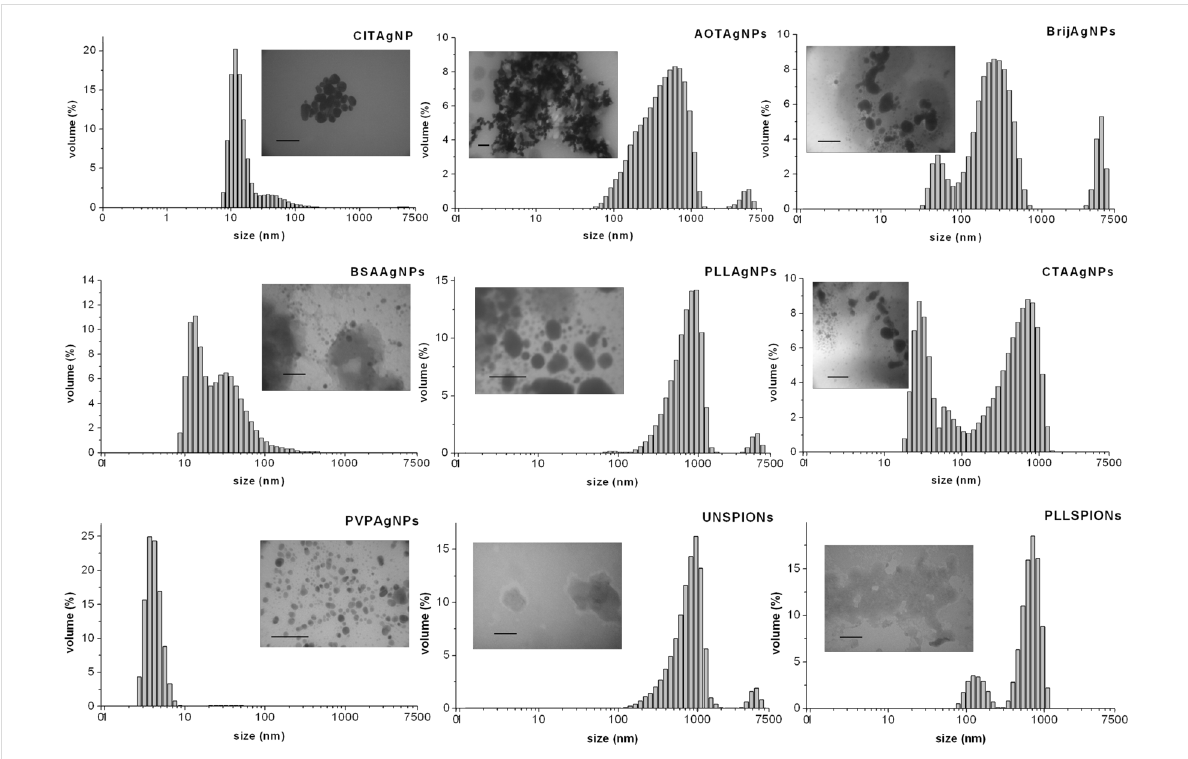
Figure 6: Transmission electron micrographs (TEM) and corresponding size distributions by volume of differently coated metallic nanoparticles in bio- logical media after 1 h at 25 °C. Results are presented for silver nanoparticles coated with trisodium citrate (CITAgNP), sodium bis(2-ethylhexyl) sulfo- succinate (AOTAgNP), Brij 35 (BrijAgNPs), bovine serum albumin (BSAAgNPs), poly(L-lysine) (PLLAgNP) , cetyltrimethylammonium bromide (CTAAgNP), and poly(vinylpyrrolidone) (PVPAgNP) and superparamagnetic iron oxide nanoparticles uncoated (UNSPION) and coated with poly(L- lysine) (PLLSPION). Scale bars are 100